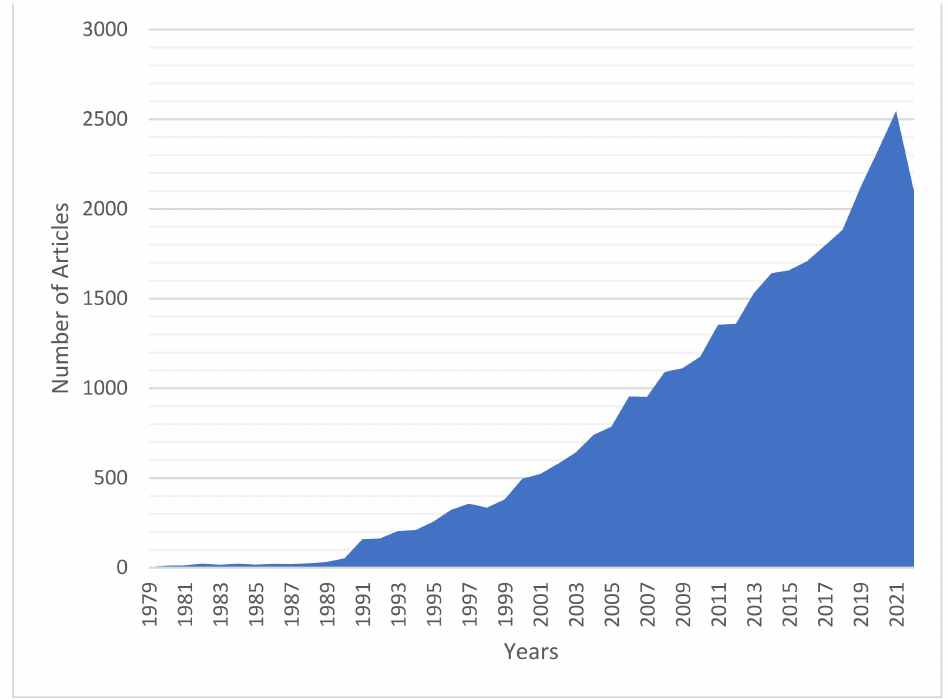
Figure 1. Number of published articles on forest fires by